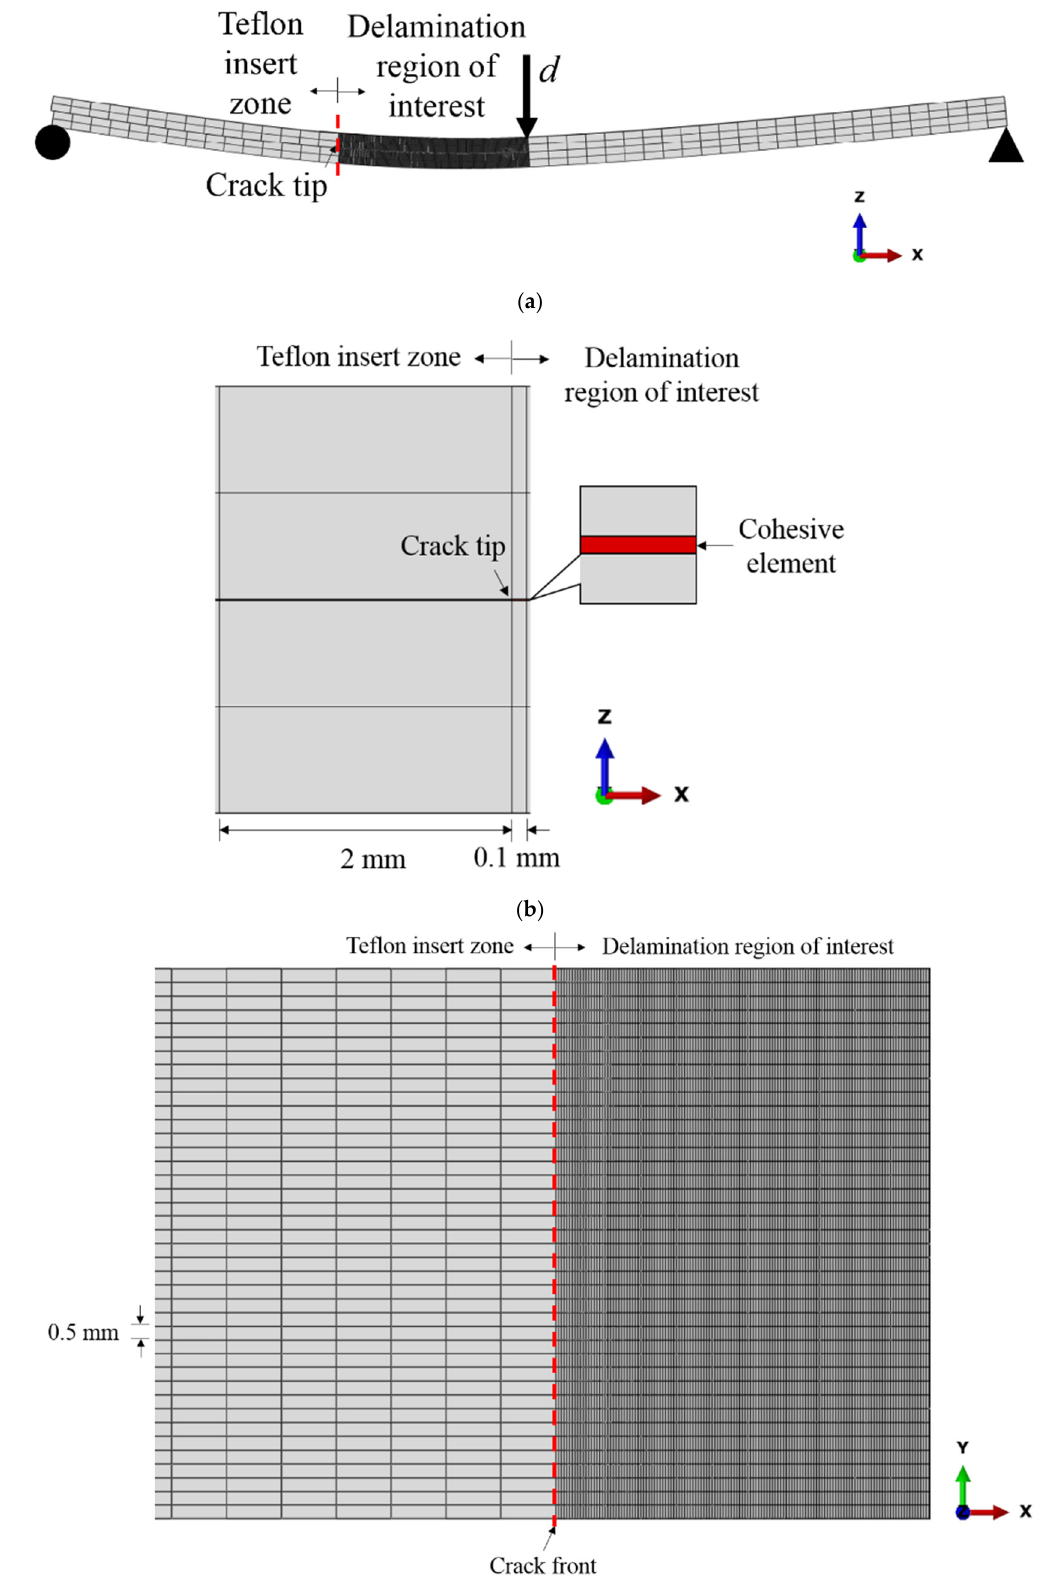
Figure 10. ( a ) Finite element model of the ENF specimen, ( b ) close-up view of the crack tip location (side view) and ( c ) top view near the crack tip location with y -axis indicating the width direction.